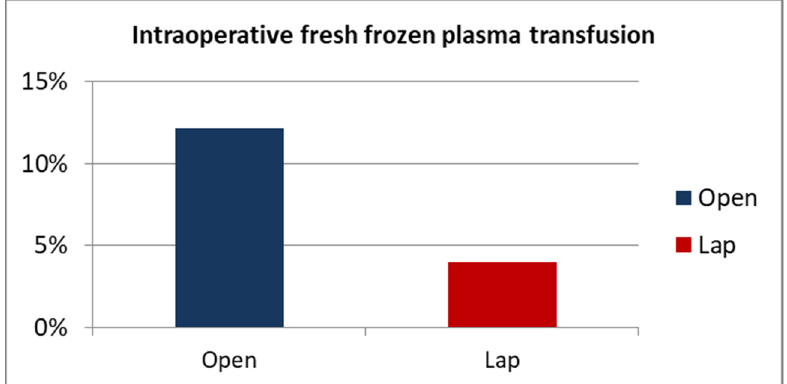
Figure 4. Intraoperative FFP transfusion ORC vs. LRC percentage.